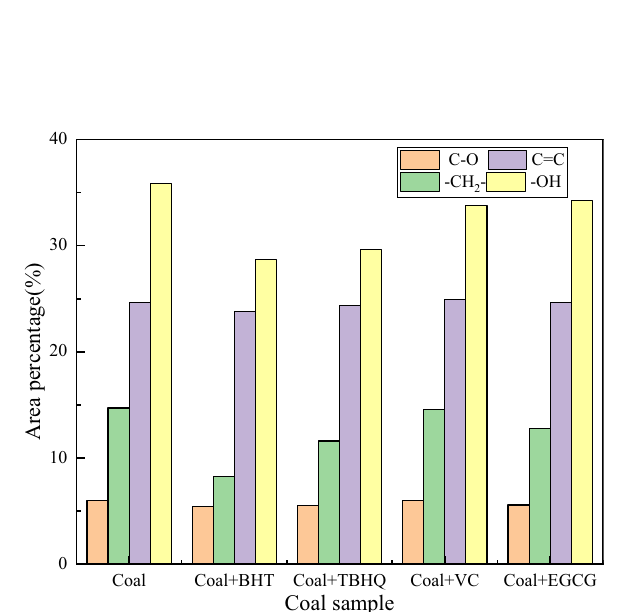
Figure 5. Relative content of functional groups in coal treated with different